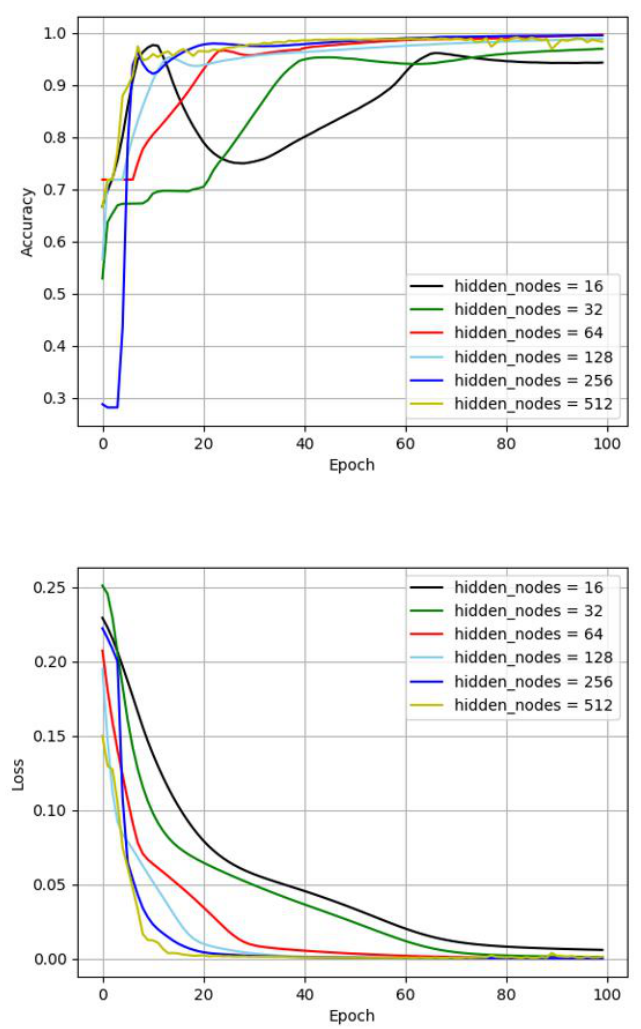
Figure 14. Localization accuracy and network loss of training data in terms of number of hidden